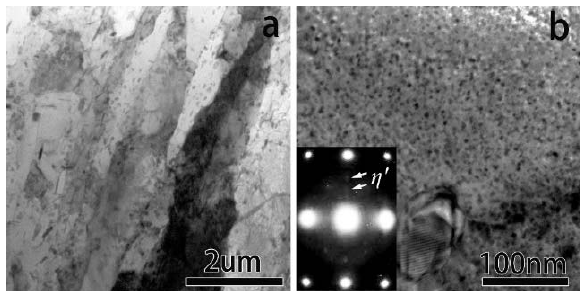
Figure 6. Microstructures in T6-treated base metal, ( a ) indicates that grains in the base metal contain a relatively low dislocation density, the inset in ( b ) is the corresponding SAED pattern.